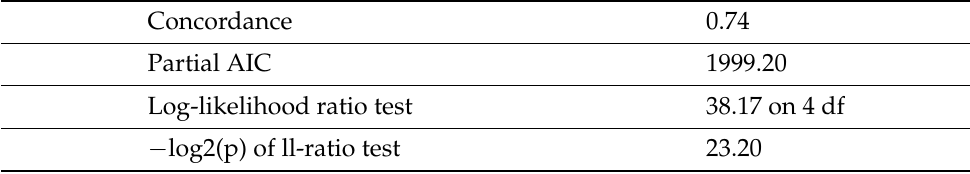
Table 6. Concordance results of the CoxPH model.